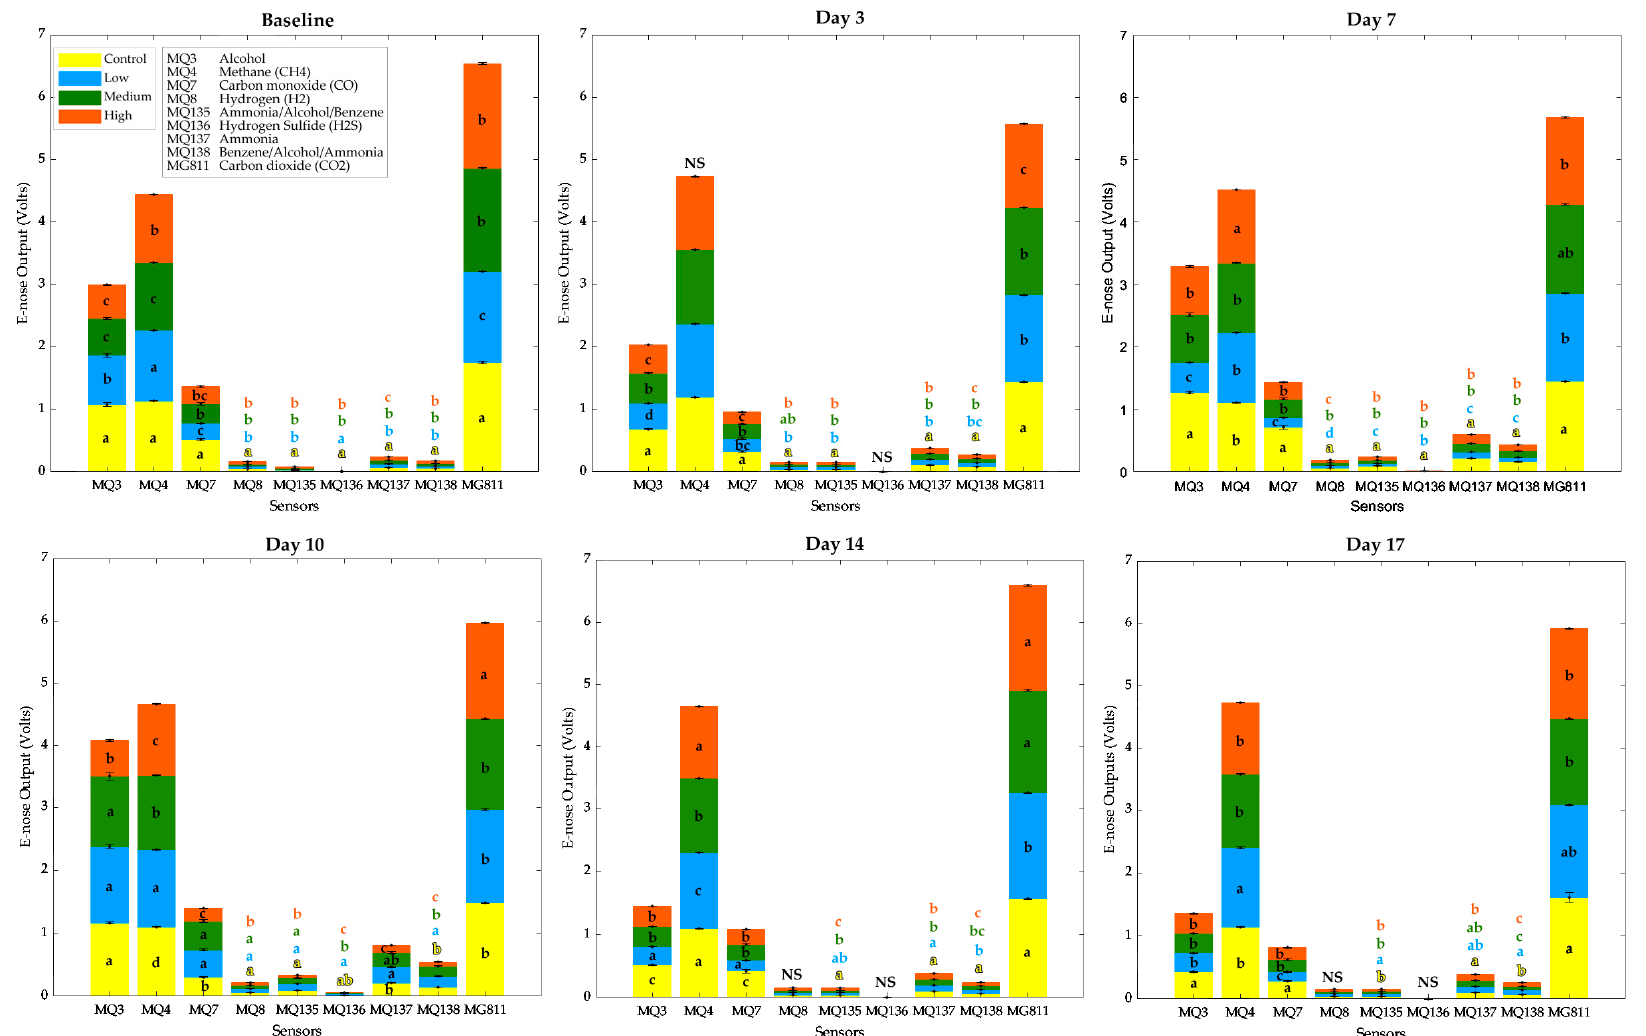
Figure 6. Electronic nose (e-nose) outputs (means) for each integrated sensor at each day of measurements. Error bars are based on standard error, and different letters denote significant differences between treatments according to ANOVA ( p < 0.05) and Tukey honestly significant difference post hoc test ( α = 0.05).